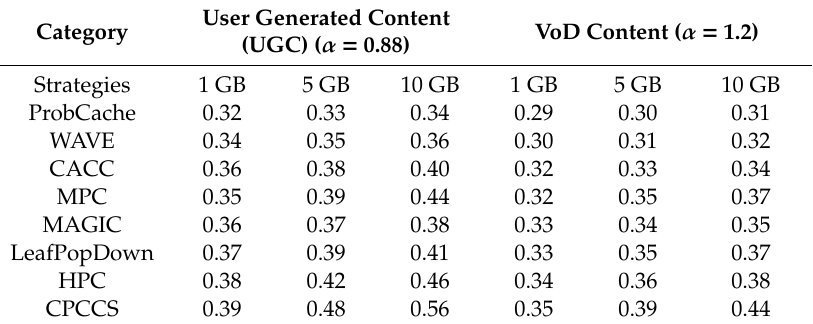
Table 1. Numerical values on cache hit